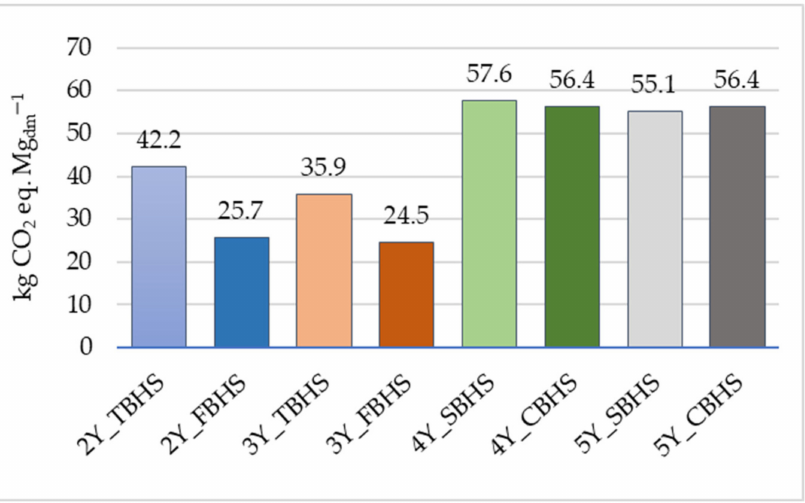
Figure 4. Emissions per Mg dm of biomass produced (in kg CO 2 eq) with reference to the TBHS, FBHS, CBHS and SBHS harvesting systems, considering storage losses and excluding emissions from all other agricultural practices (IPCC GWP